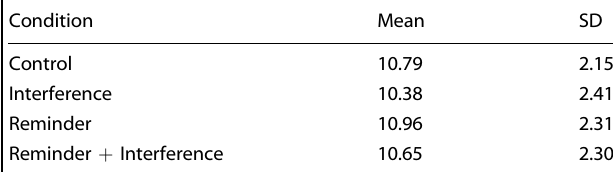
Table 5. Recognition accuracy mean and SD scores in Experiment